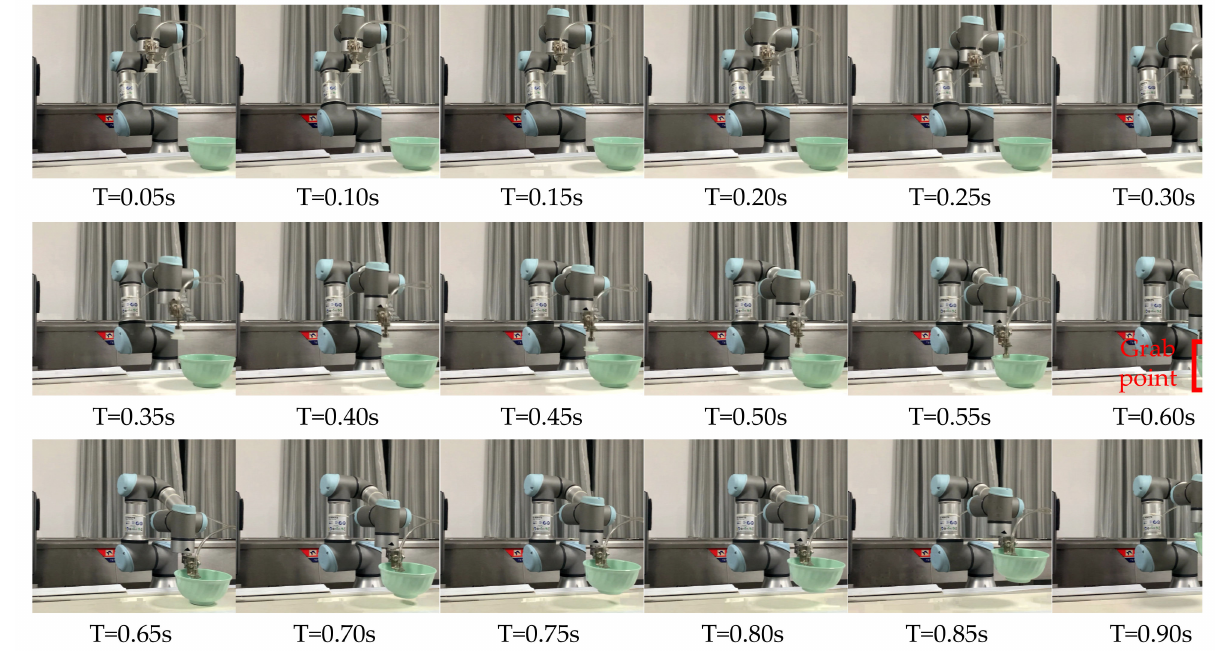
Figure 21. Tracking and grabbing